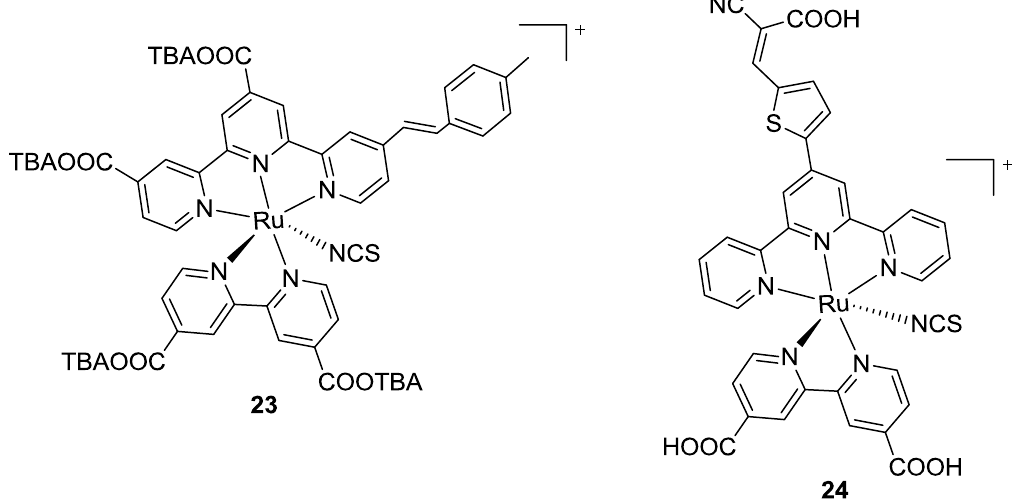
Figure 18. Four ( 23 ) and three ( 24 ) anchored complexes by Pavan Kumar [101] and Kanniyambatti [76].